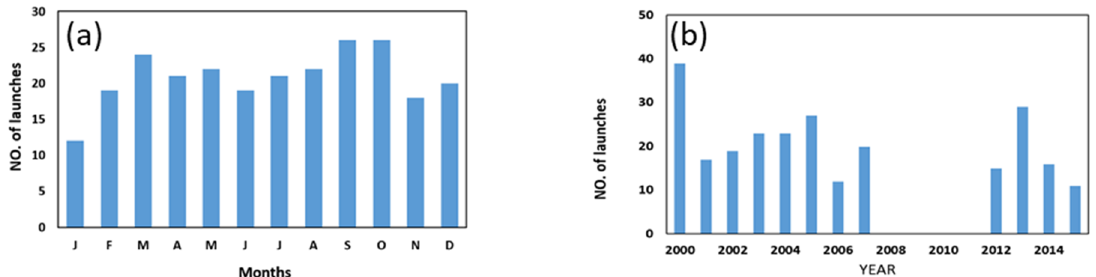
Figure 1. Number of ozonesondes launched at Irene from 2000 to 2015, expressed ( a ) monthly and ( b ) annually.